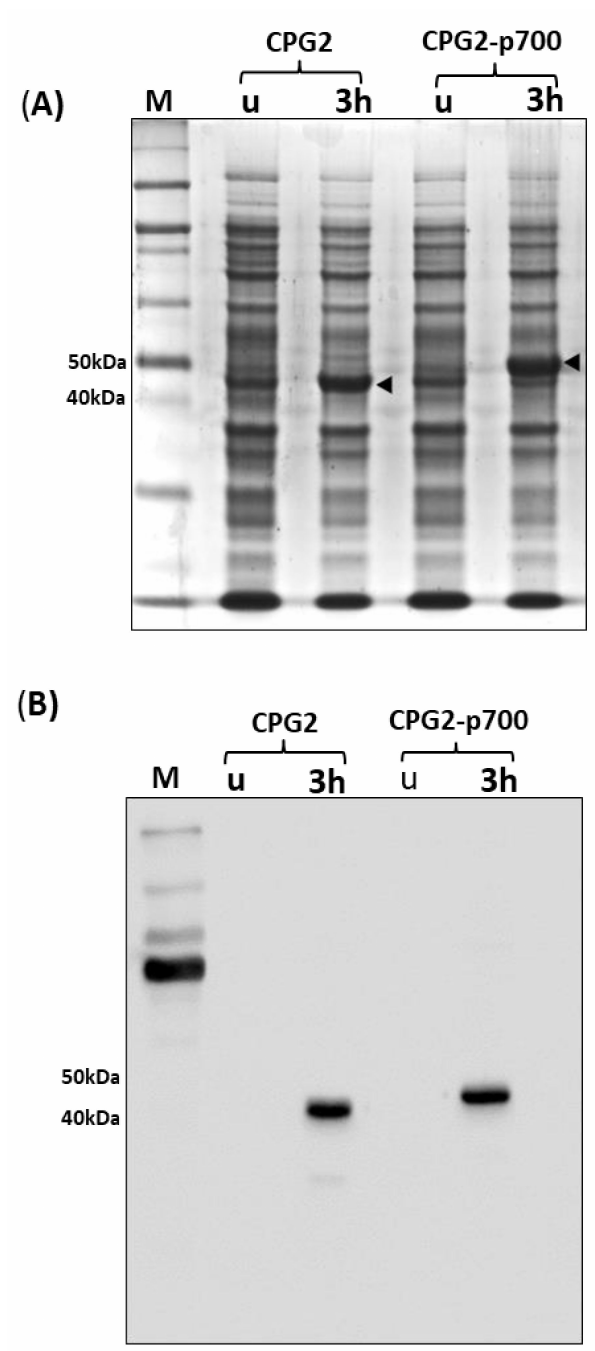
Figure 2. Large-scale expression of CPG2 recombinant proteins in BL21 E. coli . Panel ( A ) Coomassie blue staining following SDS-PAGE of paired samples (whole cell lysate) taken pre- (u) and 3 h post-IPTG induction (3 h) of CPG2, and CPG2-p700 recombinant protein expression, respectively, from left to right, compared with a ladder (extreme left). The arrowheads highlight the protein bands of the expected sizes (45 and 48 kDa). Panel ( B ) Western blotting analysis using antihistidine antibody on identical samples corresponding to the top panel, compared with a protein ladder (extreme left). Histidine-tagged recombinant proteins of the expected sizes (45 and 48 kDa) were detected in post-induction samples, but not in corresponding pre-induction